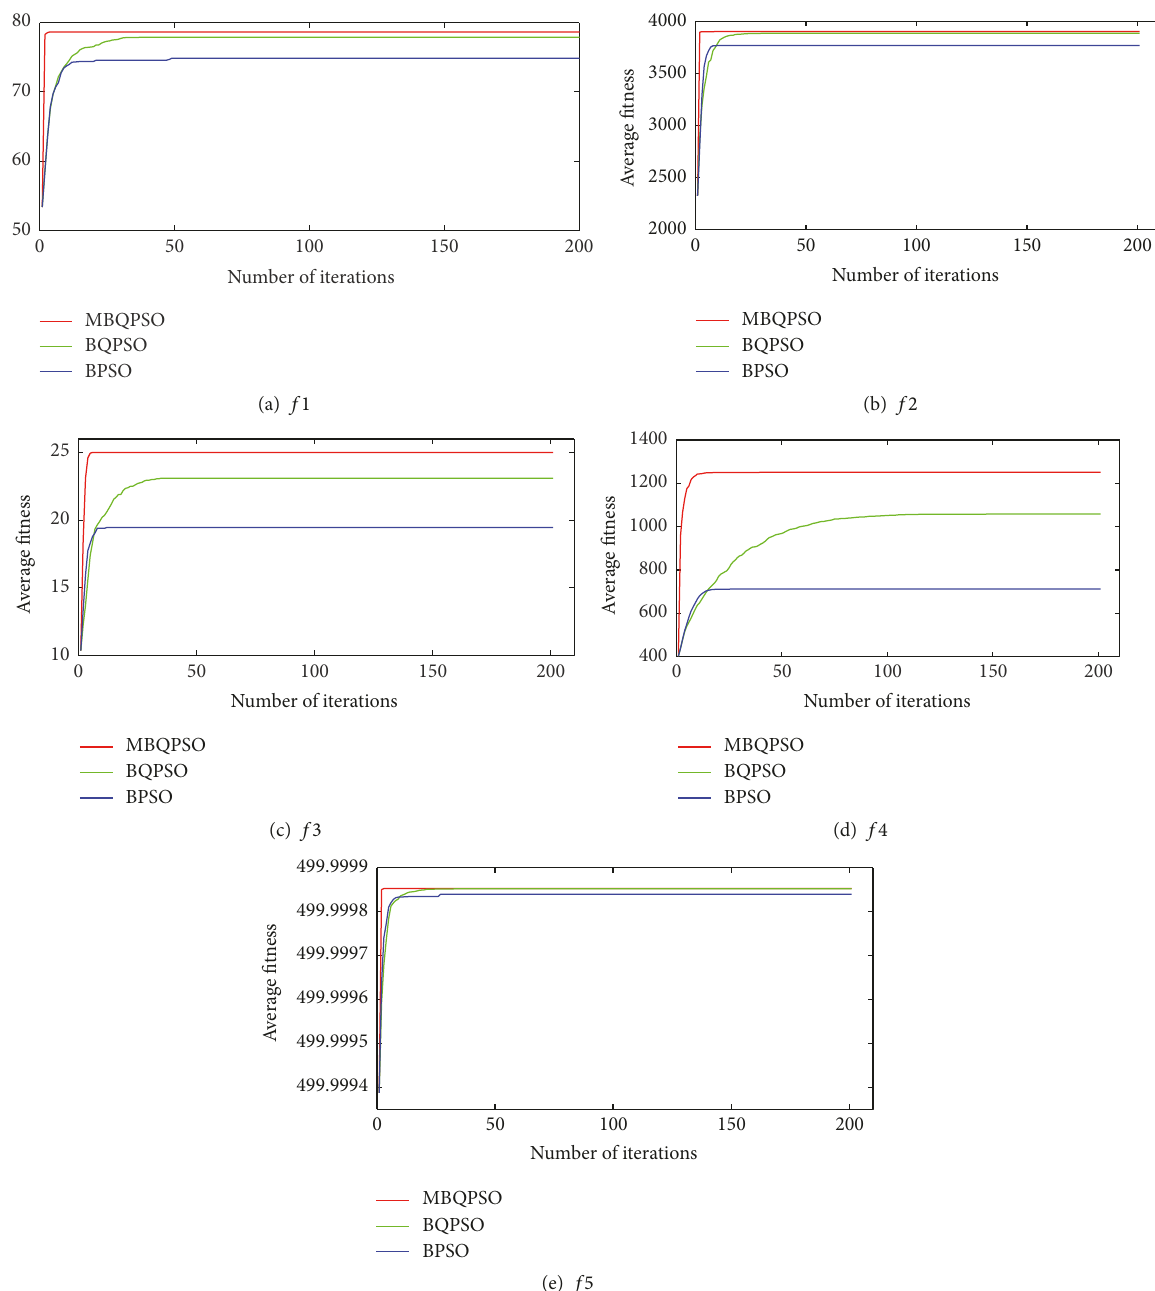
simulation test and the number of groups is 20, 40, and